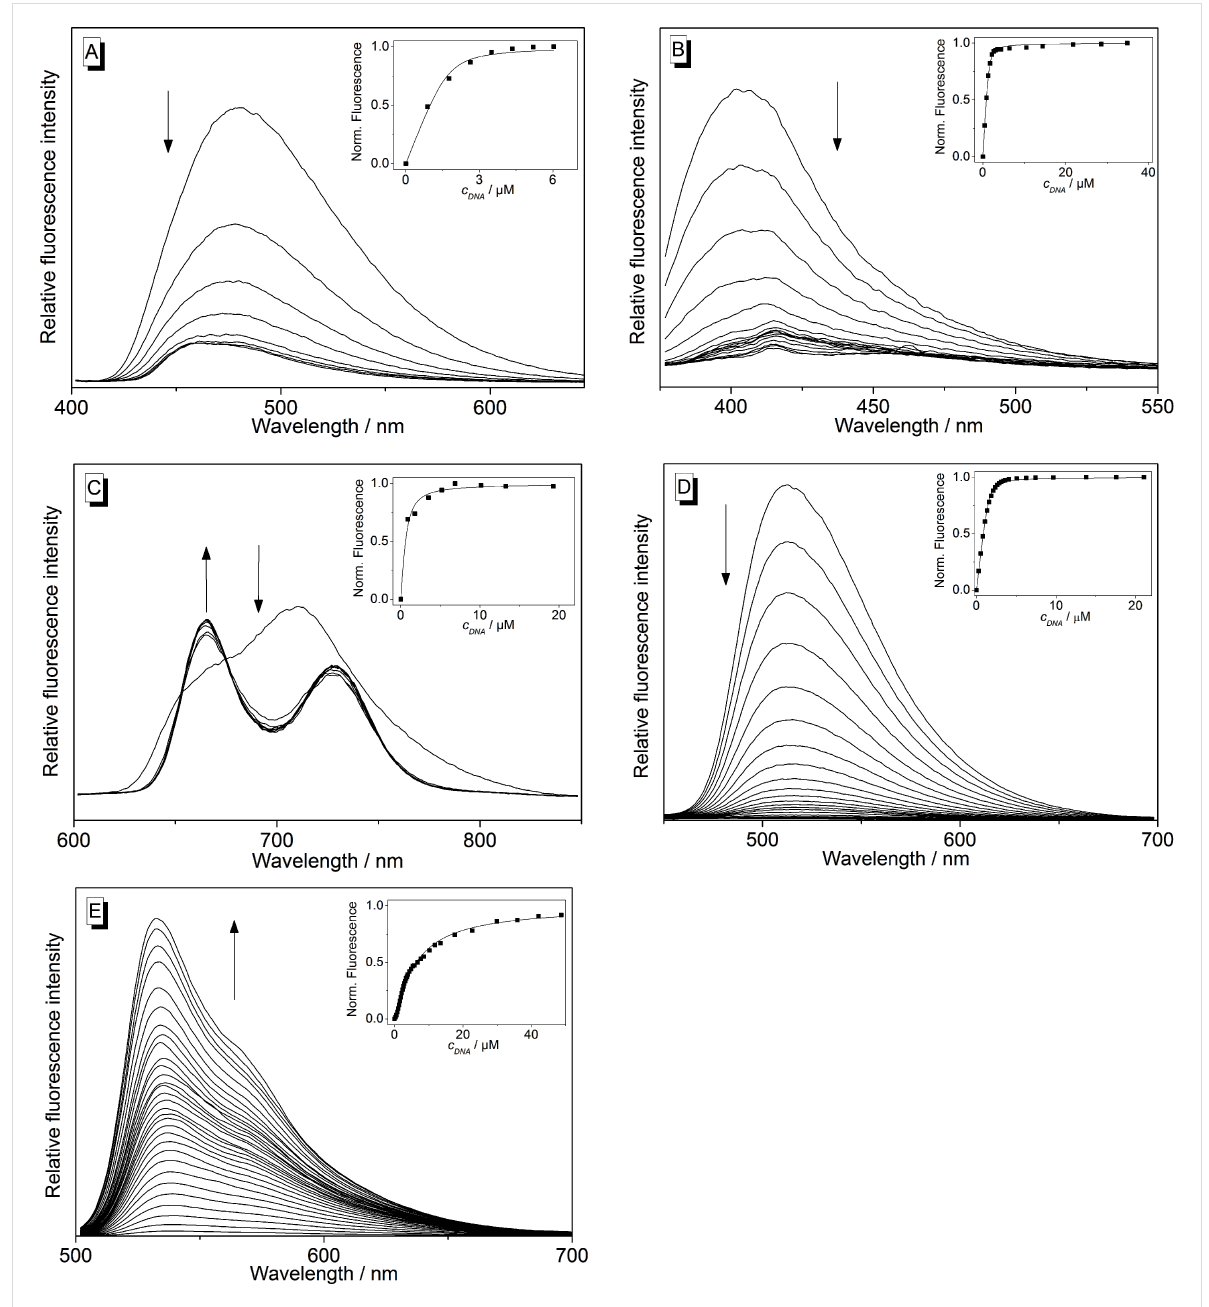
Figure 6: Fluorimetric titration of 2 (A), 3 (B), 4 (C), 5 (D) and 6 (E) with a2 in potassium phosphate buffer (95 mM, pH 7.0); A, B, D, E: c Lig = 5.0 μ M; C: c Lig = 10 μ M; A, D: λ ex = 385 nm; B: λ ex = 364 nm; C: λ ex = 431 nm; E: λ ex = 490 nm. Inset: Plot of the change of the emission intensity versus DNA concentration. Lines denote the best fit of experimental data to the theoretical model. Arrows indicate the development of the bands with increasing DNA